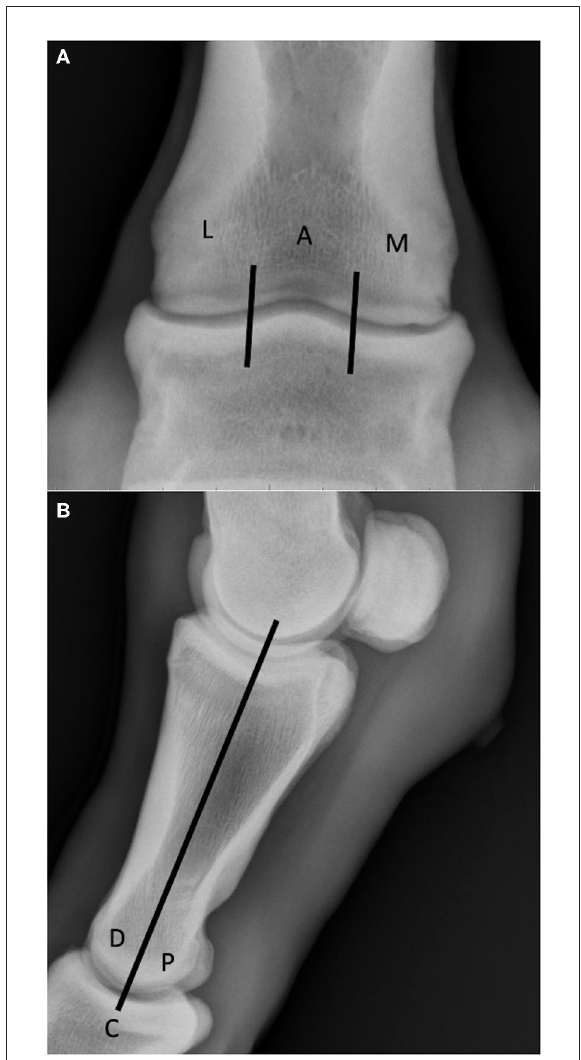
FIGURE4 (A) Lesion location on the DP radiograph was determined by dividing the joint into three equally sectioned zones: lateral (L), axial (A) and medial (M). Note the well-defined shallow concave subchondral defect in the distomedial aspect of the proximal phalanx (P1SC subtype 1). (B) Lesion location on the LM radiograph was performed by dividing the articular surfaces into two equally sectioned zones: dorsal (D) and palmar/plantar (P), and a central region at their border